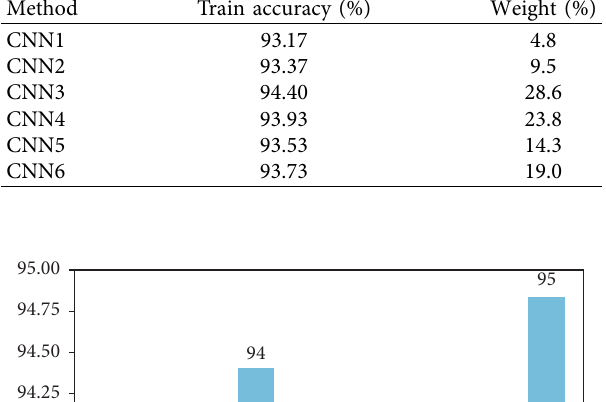
Table 3: Accuracy and weight of the classifier. Method